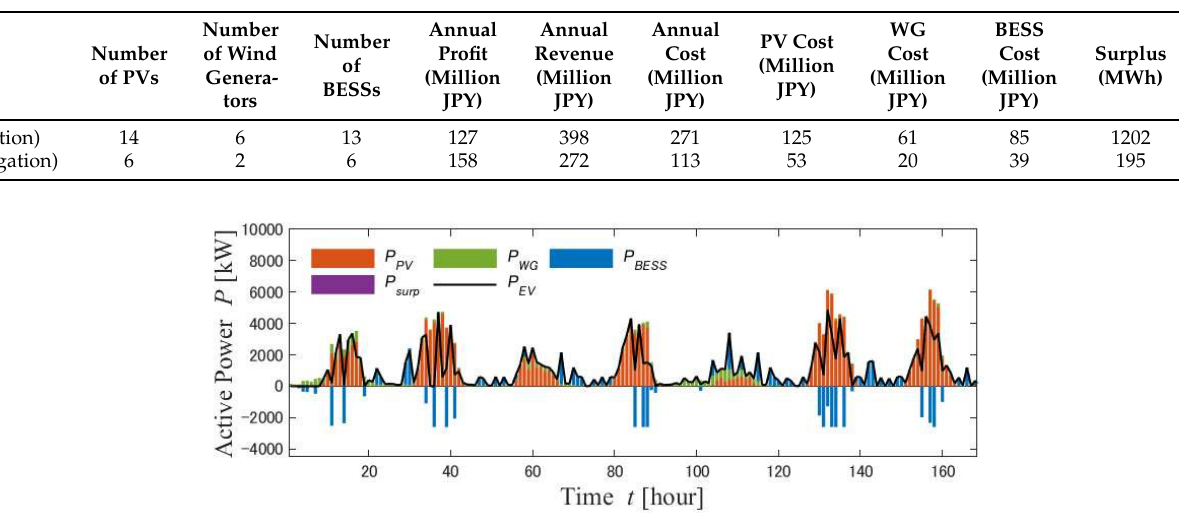
Table 7. Simulation results (when the mitigation conditions were changed).